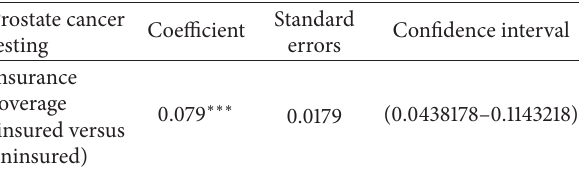
Table 6: Average effects of insurance coverage on prostate cancer testing using nearest neighbor propensity score